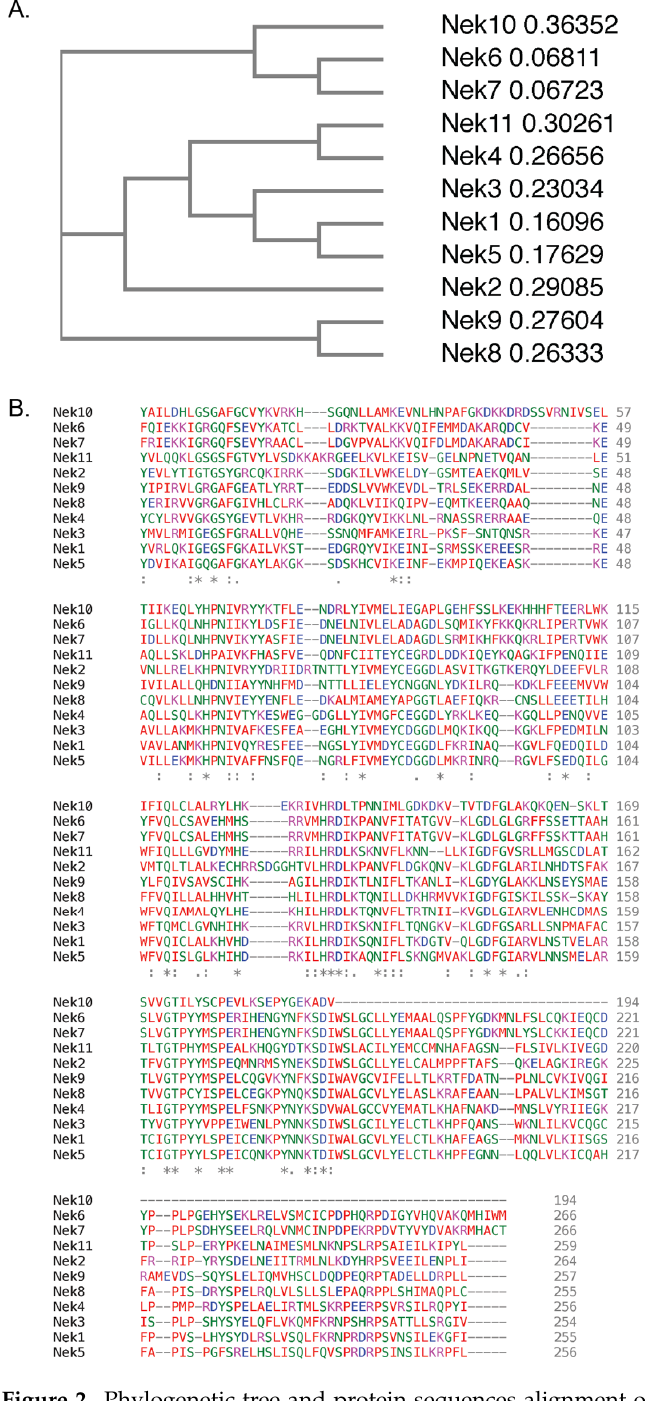
Figure 2. Phylogenetic tree and protein sequences alignment of the human Nek proteins kinase domains. All kinase domain protein sequences were obtained from UniProtKB. Protein sequences were subsequently submitted to Clustal Omega, which generated ( A ) a phylogenetic tree and ( B ) a multiple protein sequence alignment of the 11 human Nek protein kinase domains. Colours refer to amino acid properties as follows: red—small and hydrophobic including aromatic but excluding tyrosine; blue—acidic; magenta—basic excluding histidine; green—charged with hydroxyl, amine, or sulfhydryl groups, and glycine. * – fully conserved residues, : – conservation between groups of residues with strongly similar properties, . – conservation between groups of residues with weakly similar properties. The numbers next to the protein names in ( A ) refer to the sequence distance measure.